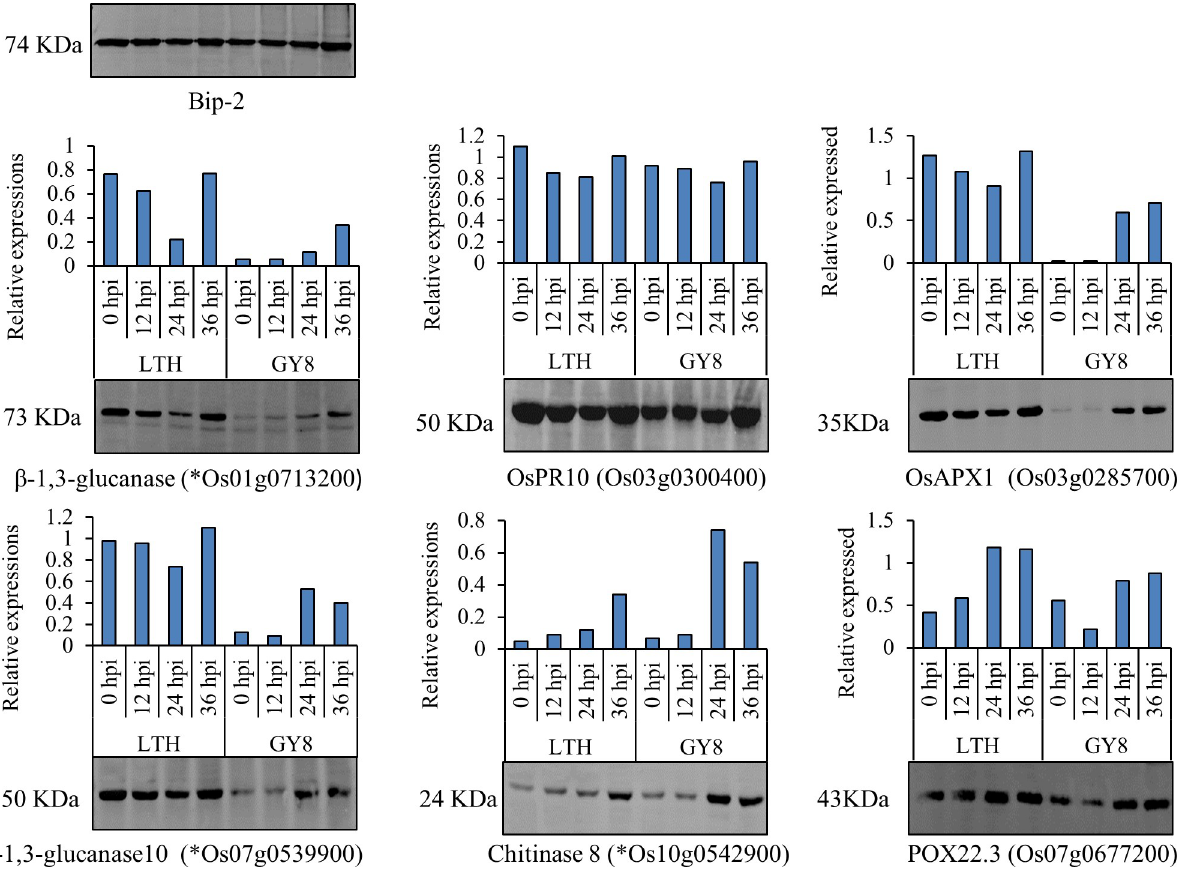
Fig 5. Results of the western blotting analyses. We use Gel-Pro Analyzer 4 software to analyze the grayscale of each band of gel image, use the grayscale as the expression of the protein. Then we calculated gray ratio of detected gene and reference gene (Bip-2) as the relative expression.